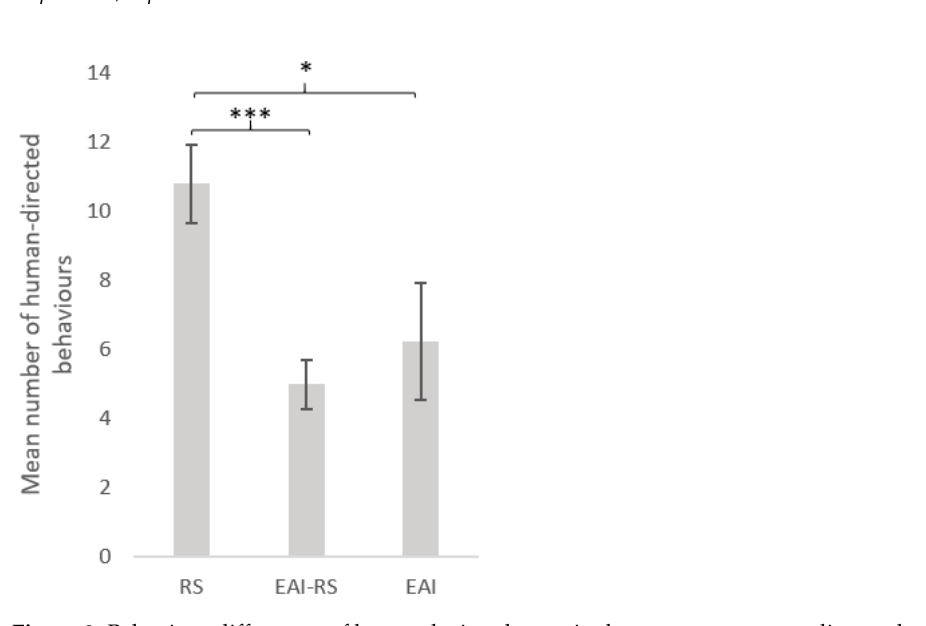
Figure 2. ( a ) Positive and ( b ) negative human-directed behaviours (mean ± SE) during the motionless person test. Tests followed by Mann–Whitney tests as post hoc tests. RS = riding school horses (N = 95), EAI = assisted-intervention horses (N = 17), EAI-RS = horse with mixed activity (N = 60). ***: p < 0.001, **: p < 0.01, *: p < 0.05, ﮲ : p < 0.1.